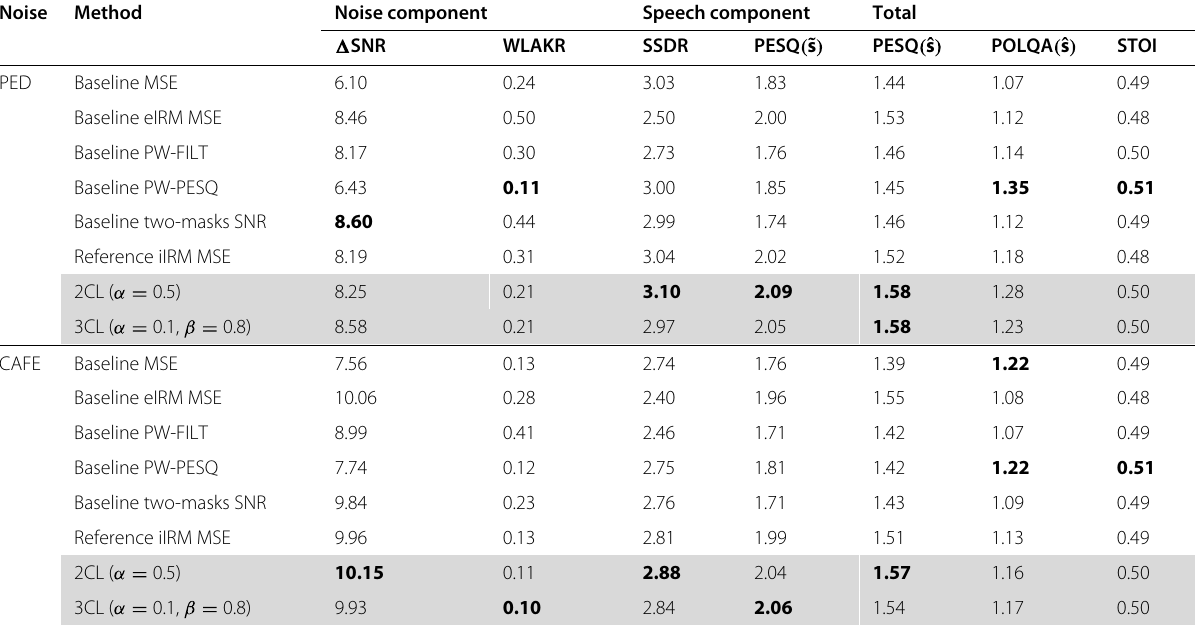
Table 7 Performance for seen noise types (PED and CAFE) on the test set ; SNR 5dB . Best approaches from Tables 1 and 3 are gray-shaded; the best scheme is in boldface Noise